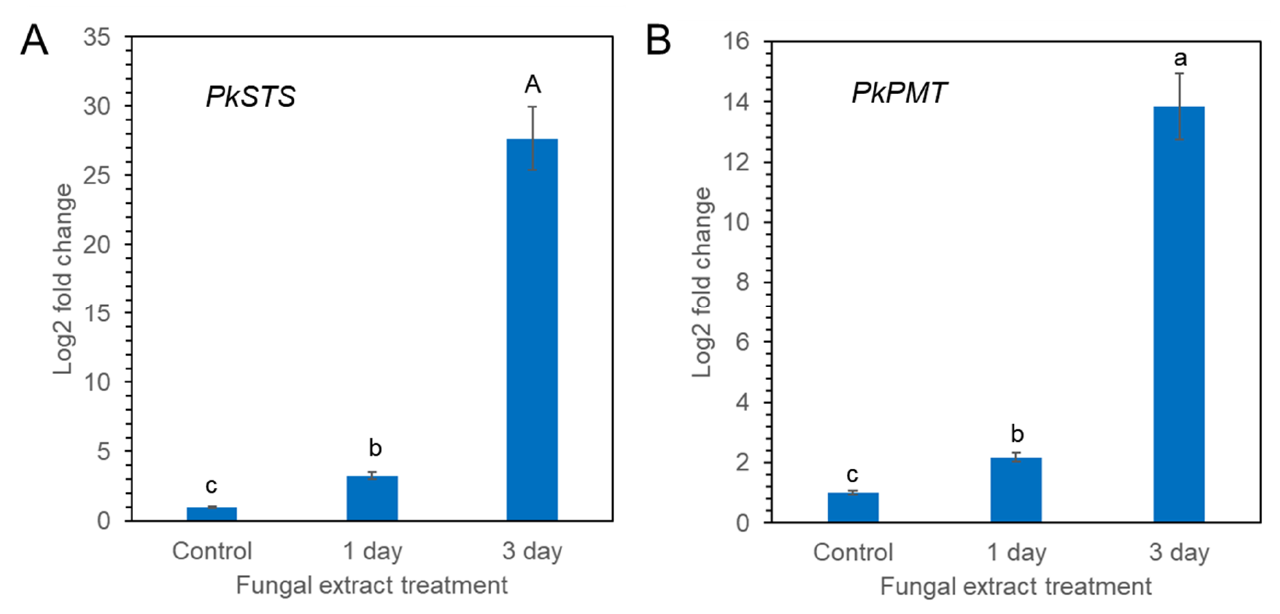
Figure 9. qPCR analysis of PkSTS ( A ) and PkPMT ( B ) genes in P. koraiensis callus after fungal elicitor ( P. chrysogenus MF) treatment. The expression data were normalized to β-actin. The vertical bars represent the mean ± SE based on three biological replicates. Different letters above the error bars indicate significantly different values ( p < 0.05), calculated using one-way ANOVA followed by Duncan's post hoc analysis .